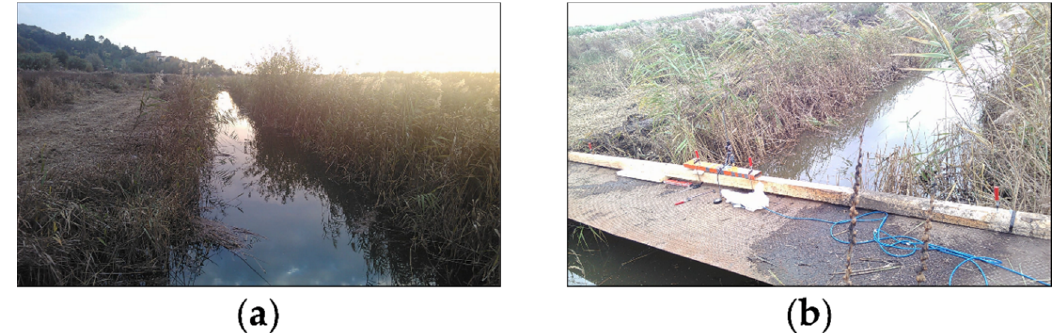
Figure 6. ( a ) Examined vegetated reclamation channel in condition of partial riparian vegetation coverage; ( b ) local ADV flow velocity measurement set-up, for the two investigated flow rate regimes